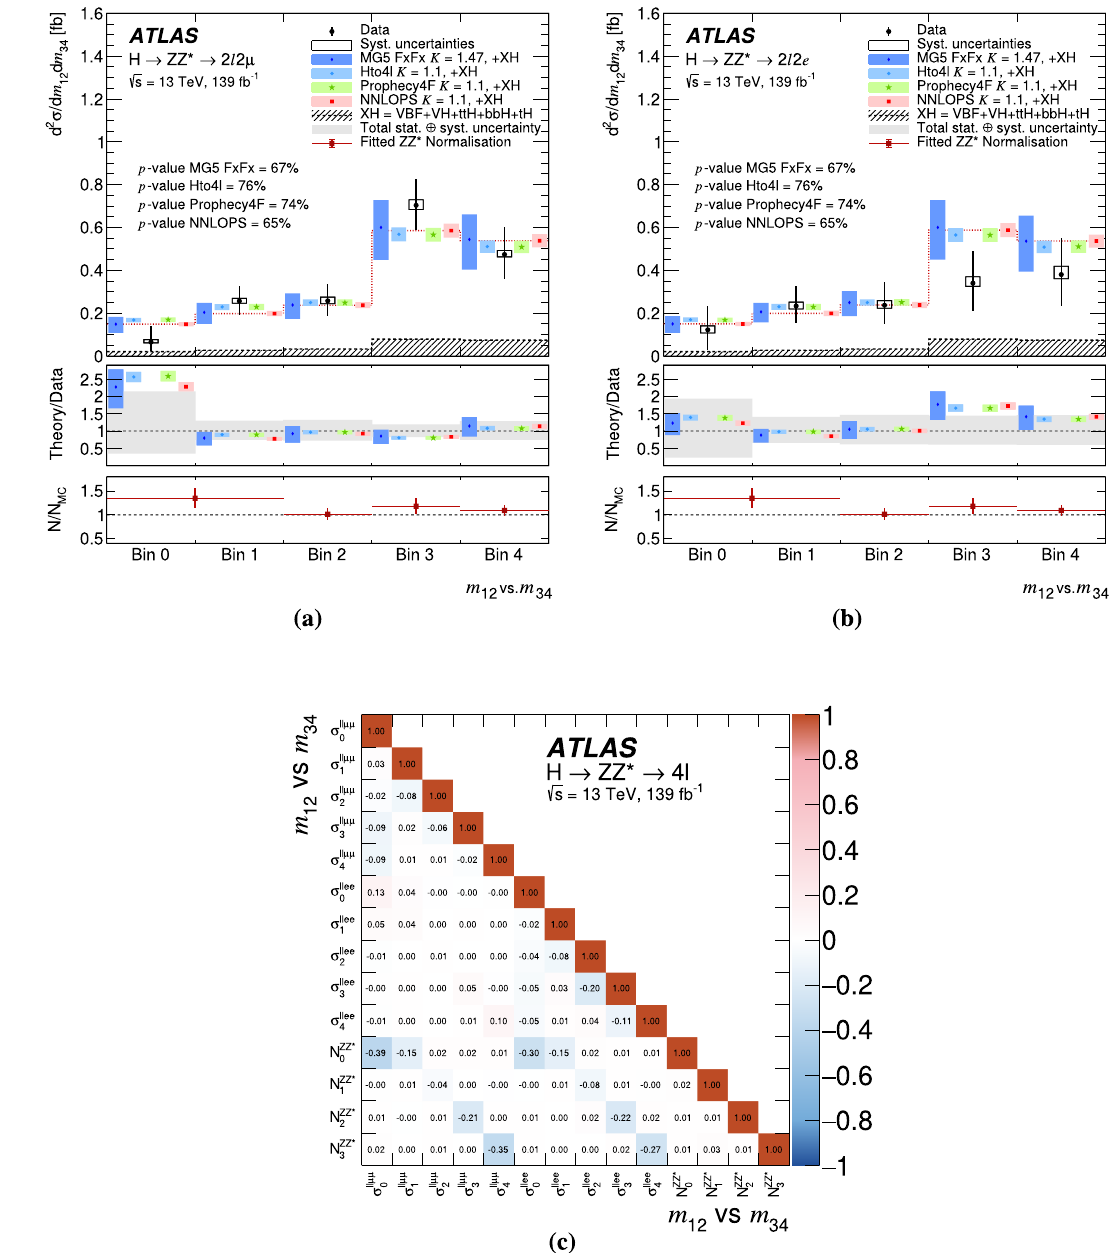
Fig. 32 Differential fiducial cross sections for the leading vs. subleading Z boson mass, m 12 vs. m 34 , in a (cid:3)(cid:3)μμ and b (cid:3)(cid:3) ee final states, along with c their corresponding correlation matrix between the measured cross sections and the Z Z ∗ background normalisation factors. The bin boundaries are defined in Fig.